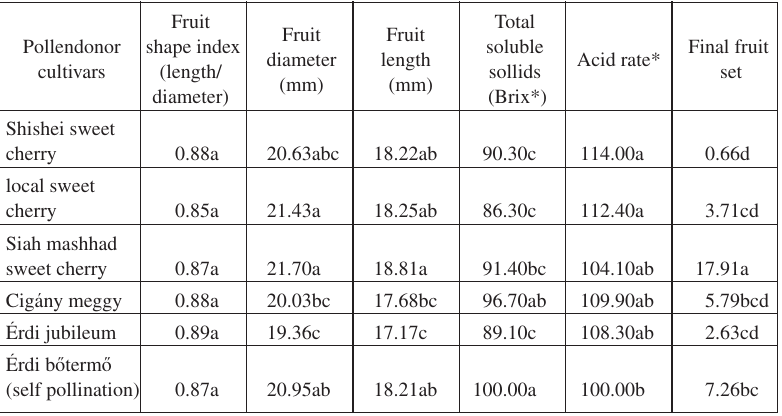
Table 5. Qualitative and quantitative traits of Érdi bôtermô cultivars obtained from cross pollination with pollinizers